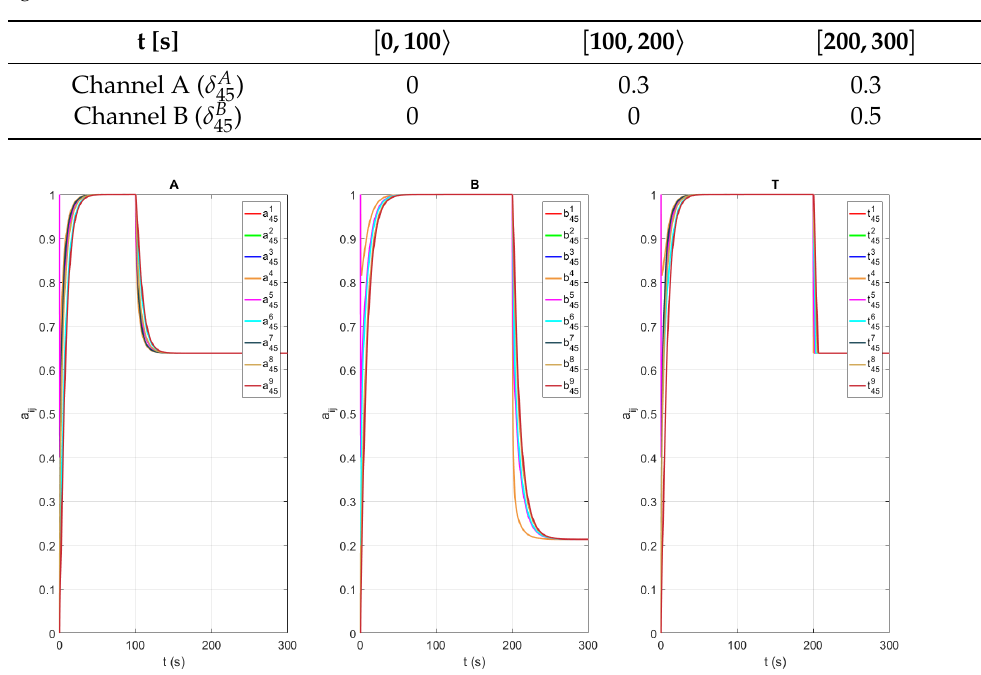
Table 1. The difference between transmitted and received number of packages for the links between agents 4 and 5 for channels A and B.